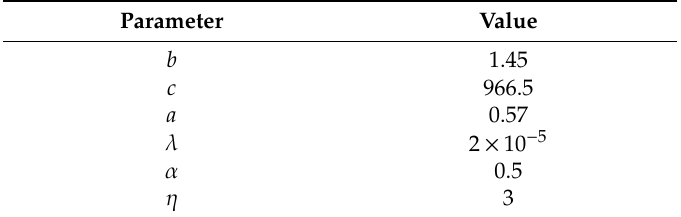
Figure 7. 90th percentile of the exposure as function of system utilization for di ff erent values of the BS density. Table 5. Parameters used in the analysis simulations for Figures 6 and